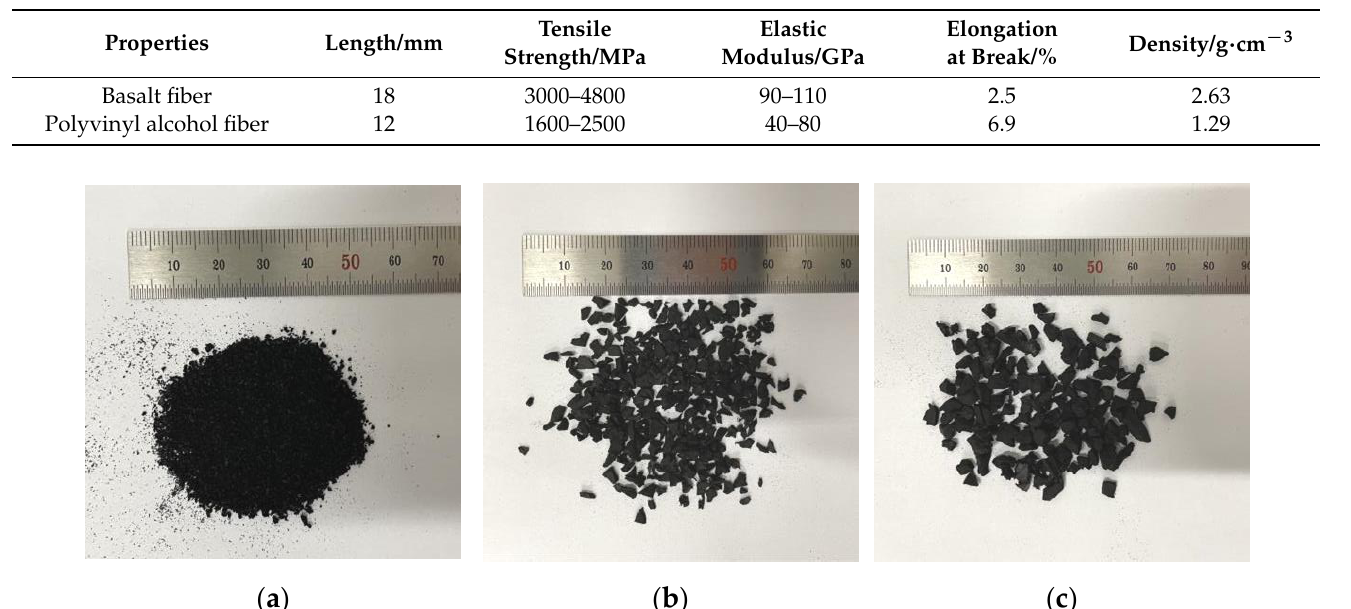
Table 4. Technical indexes of rubber particles. Table 5. The physical properties of basalt fiber and polyvinyl alcohol fiber.